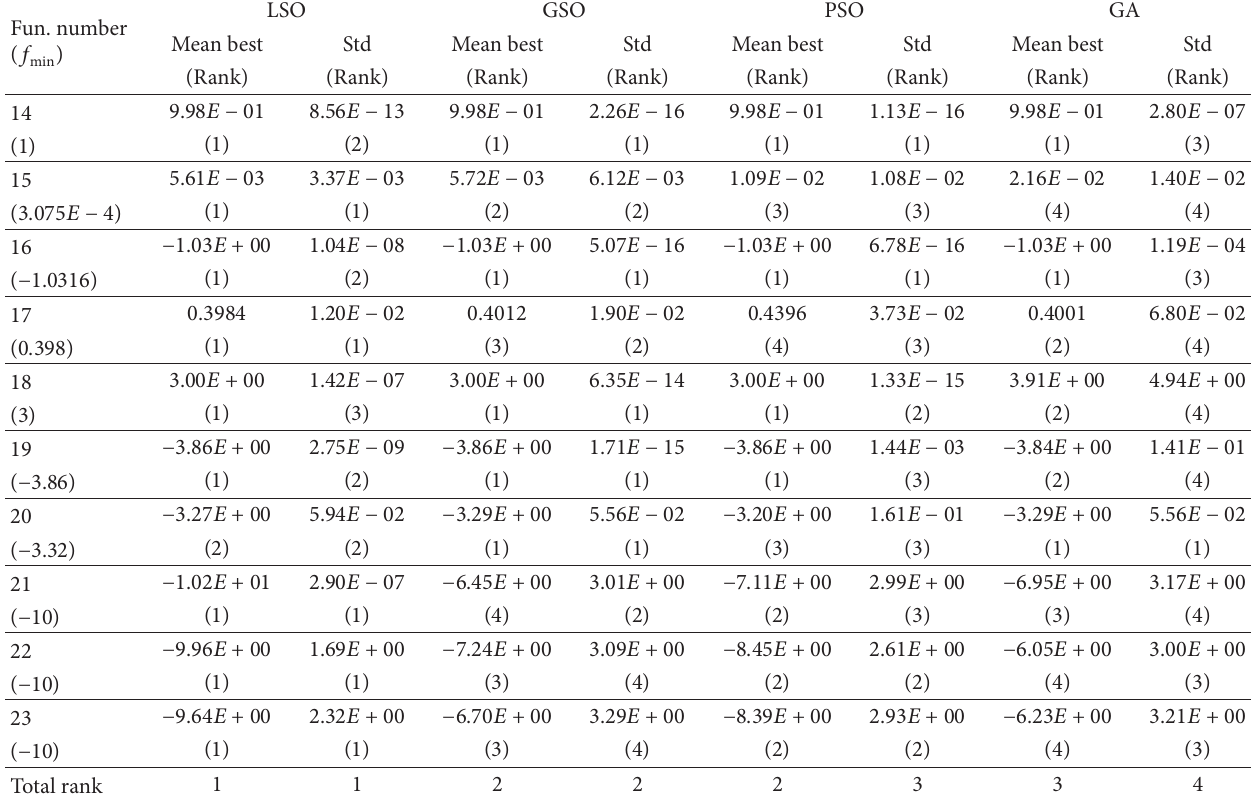
Table 3: Results for all algorithms on benchmarks functions 𝑓 14 to 𝑓 23